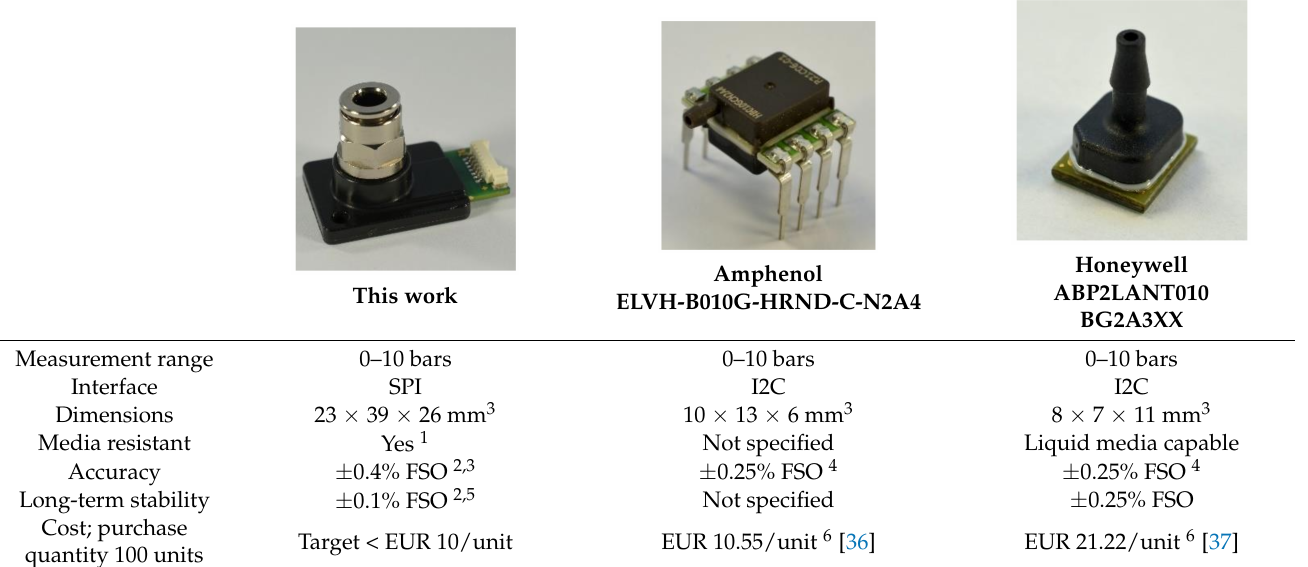
Table 4. Comparison of technical data with commercial